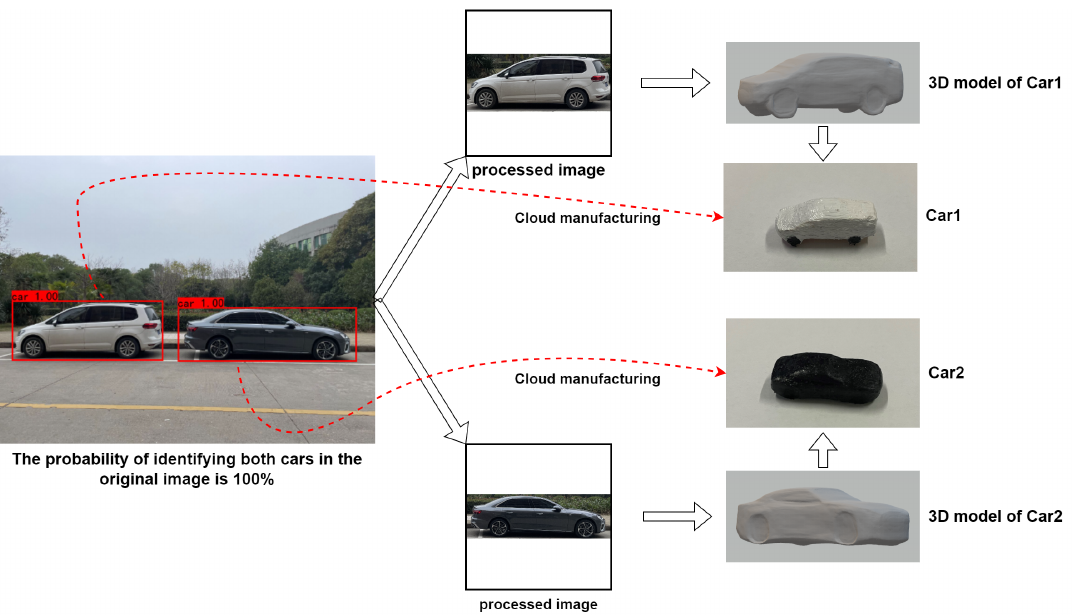
Figure 5. Two small car models with different shapes are manufactured through the proposed method.